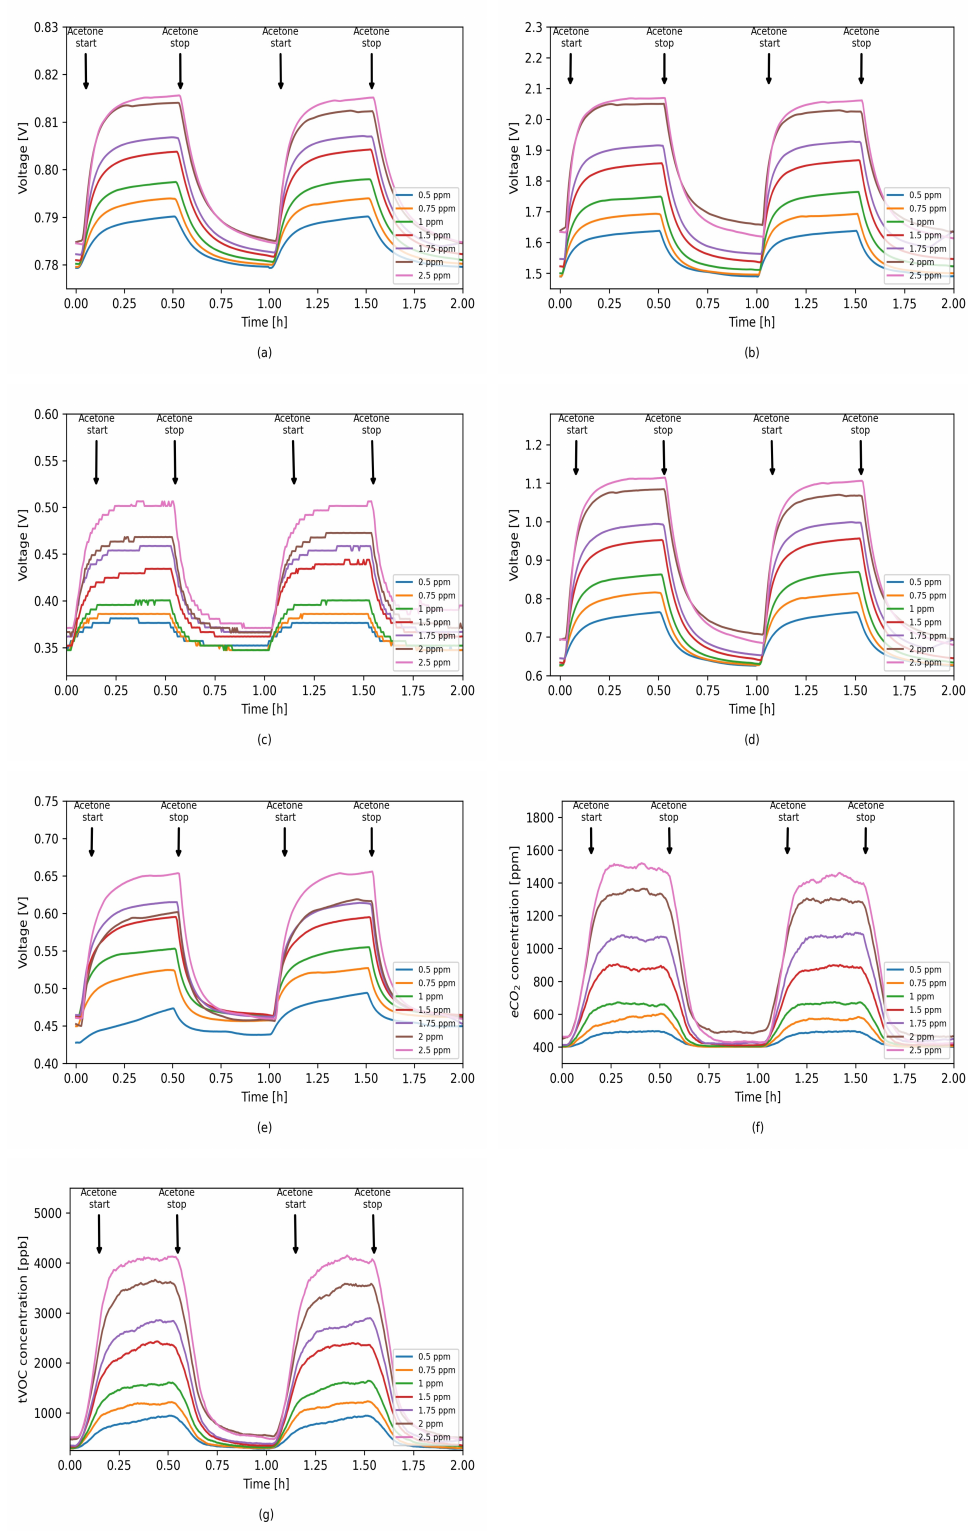
Figure 7. Sensors’ responses to different acetone concentrations in 0% RH. ( a ) TGS1820; ( b ) TGS2620; ( c ) TGS8100; ( d ) MQ3; ( e ) MICS5524; ( f ) SGP30 eCO2; ( g ) SGP30